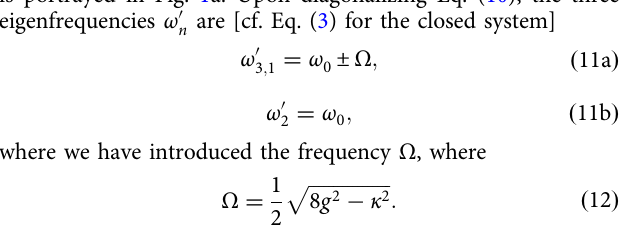
lower eigenfrequencies ω 0